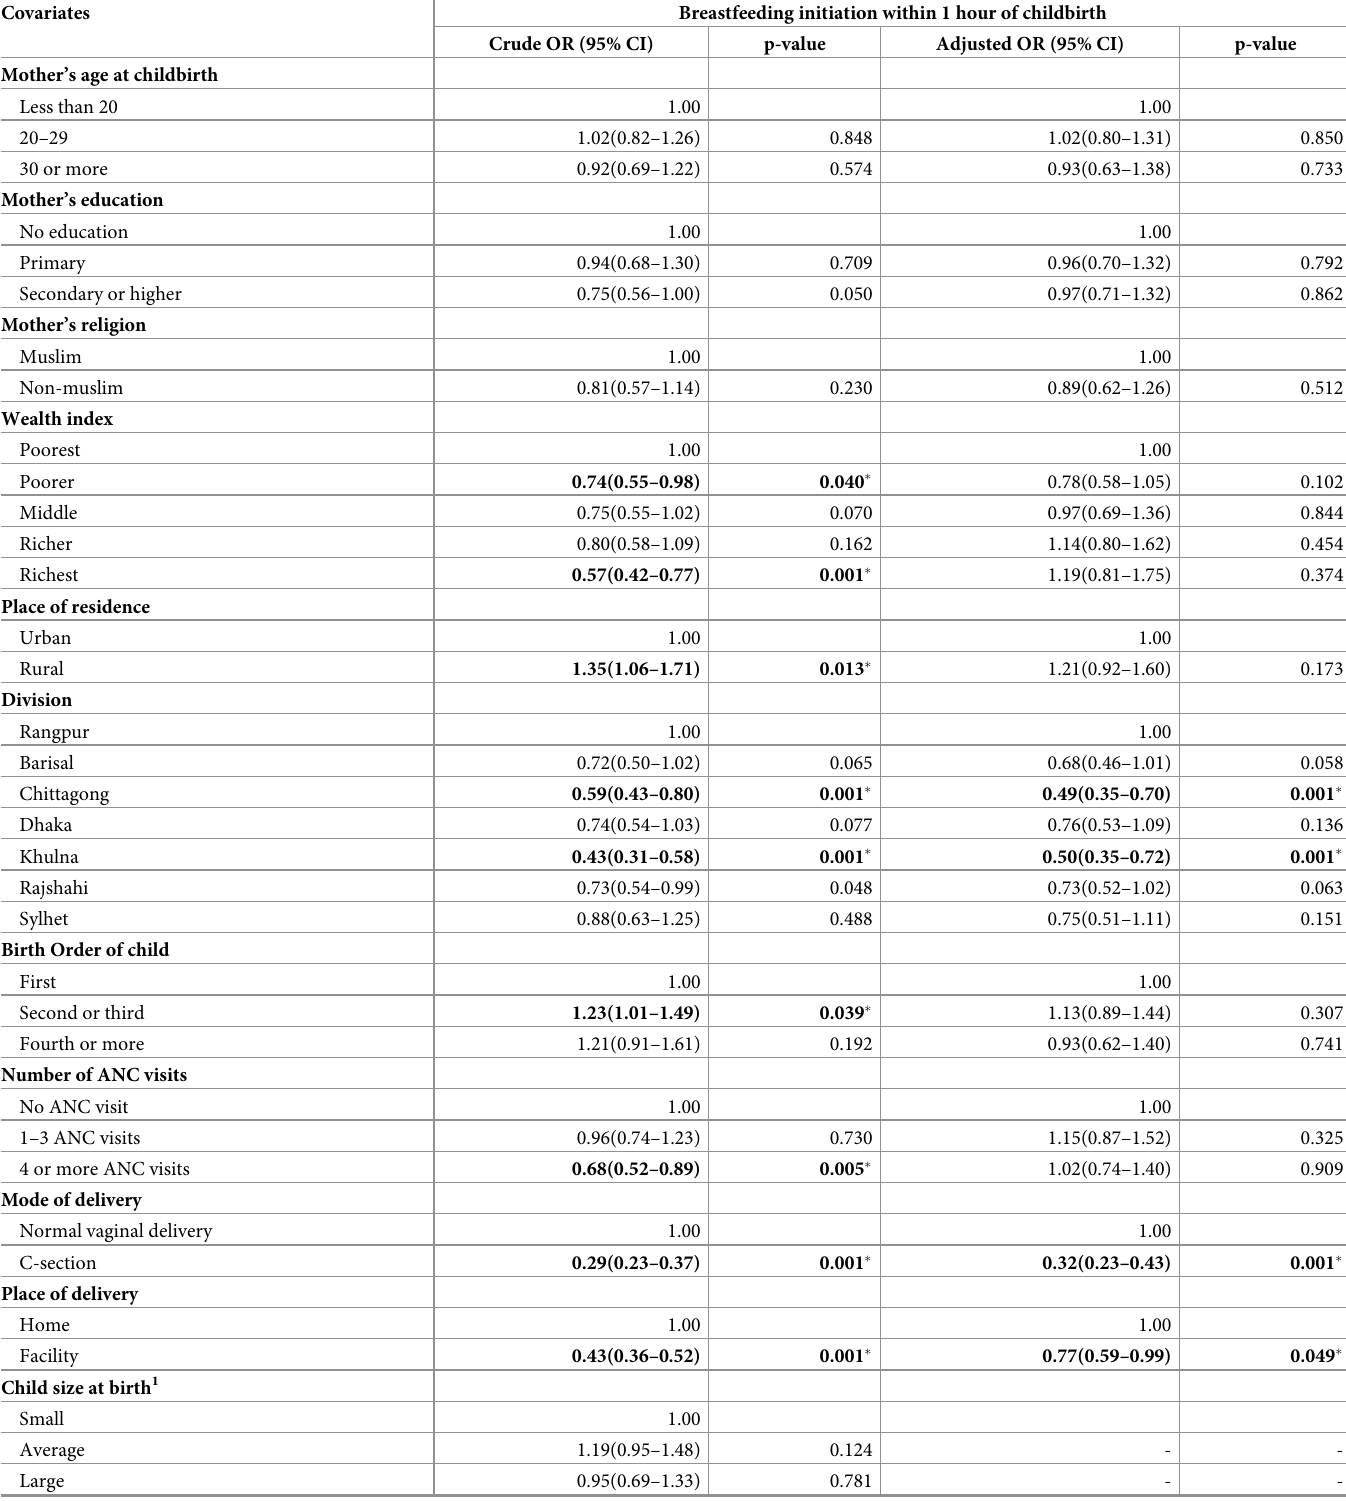
Table 2. Crude (unadjusted) and adjusted odds ratios of determinants of early initiation of